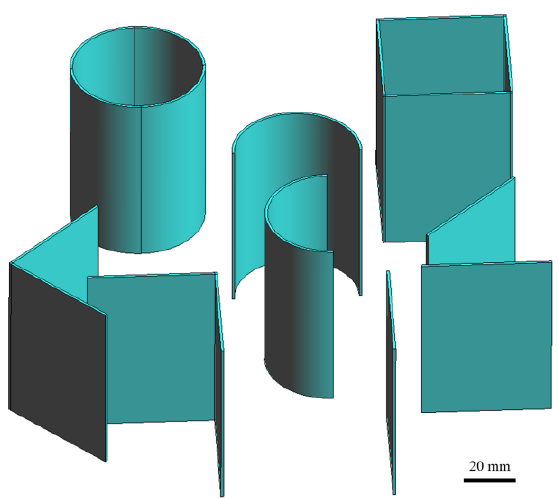
Figure 2. Nominal CAD models of different thin-walled structures sent to the slic- ing tool to generate the scanning sequence for the SLM